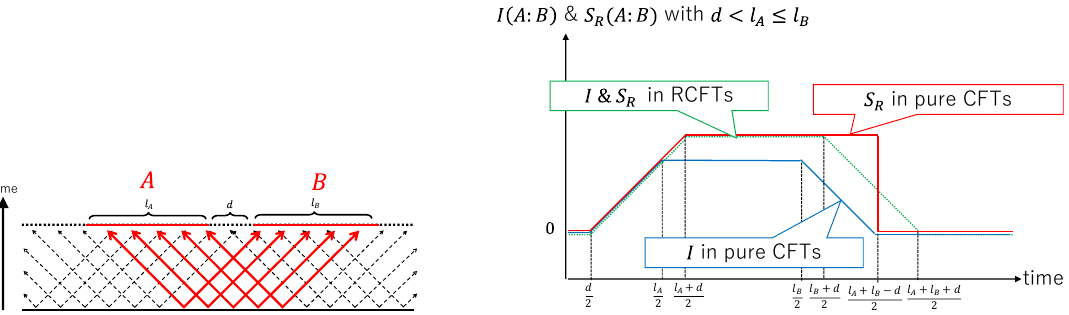
Figure 11 . Left: the generalized setup with di(cid:11)erent subsystem sizes l A and l B . Right: the time evolution when d < l A (cid:20) l B . One can (cid:12)nd a new plateau that lasts for a time equal to l B (cid:0) l A